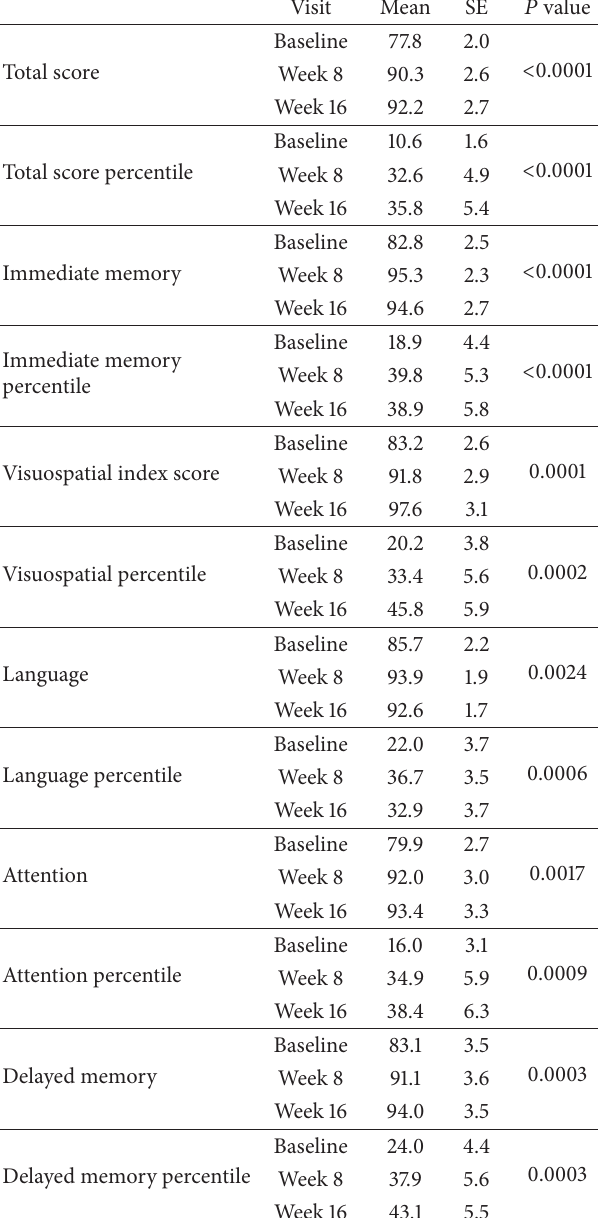
Table 2: Change in RBANS scores during repeated measures. Table 3: Estimated means and standard errors for secondary out- come scores at each visit (from ME model).